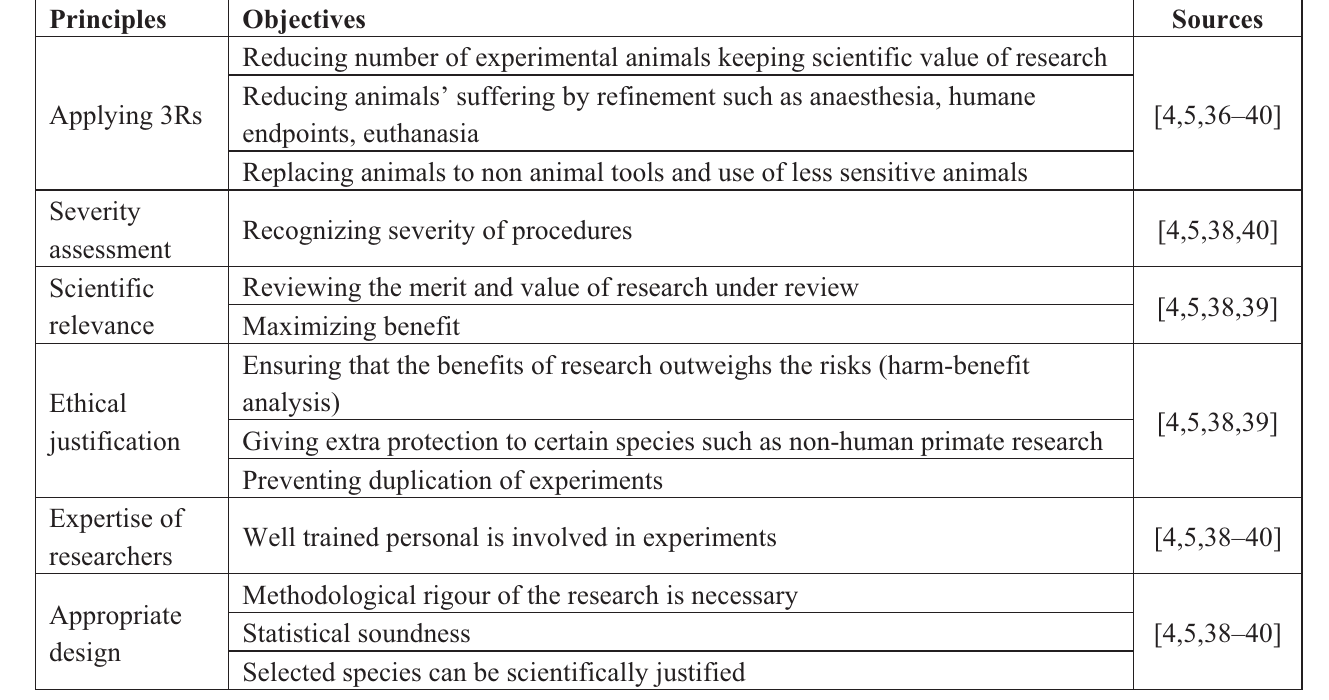
Table 4. Objectives of legislation regulating animal research use with